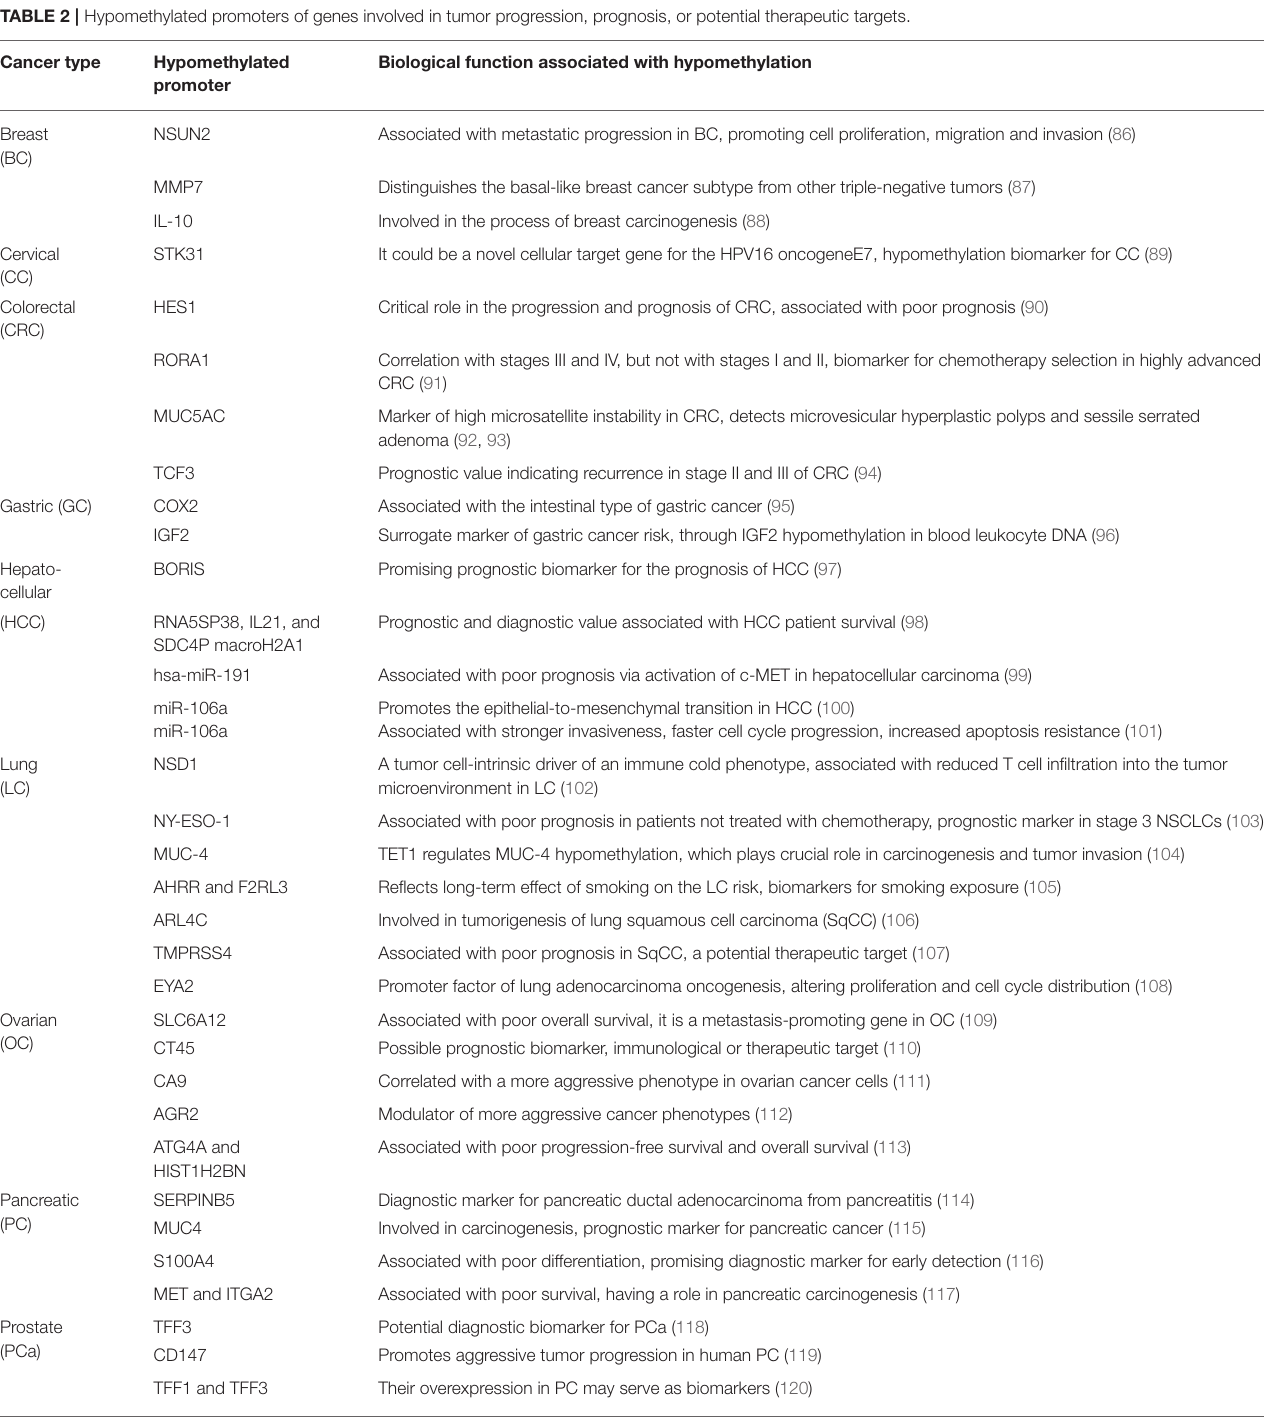
TABLE 2 | Hypomethylated promoters of genes involved in tumor progression, prognosis, or potential therapeutic targets. Cancer